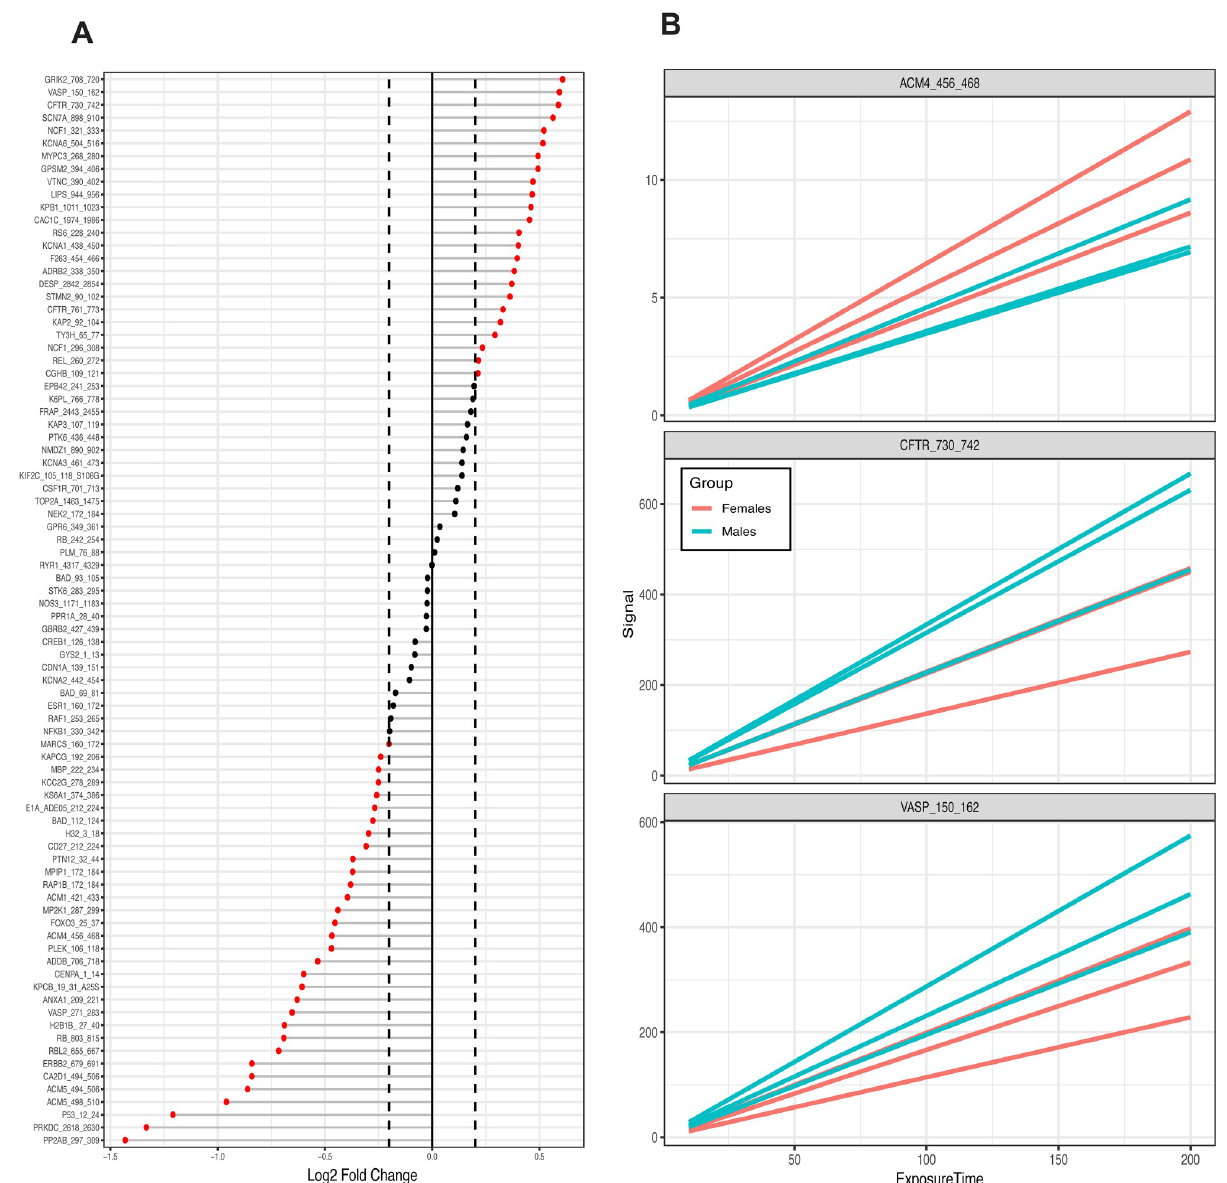
Fig 3. Changes in phosphorylation at reporter peptides in female vs. male DLPFC. (A) Waterfall plot showing log2 fold changes (LFC) in phosphorylation at reporter peptides for female vs. male DLPFC. Peptides with positive LFC indicate higher phosphorylation in males, and peptides with negative LFC indicates lower phosphorylation in males. The dashed line indicates the 0.2 LFC cutoff (B) Representative examples of linear model fit of the phosphorylation curves of three reporter peptides in female vs. male DLPFC.